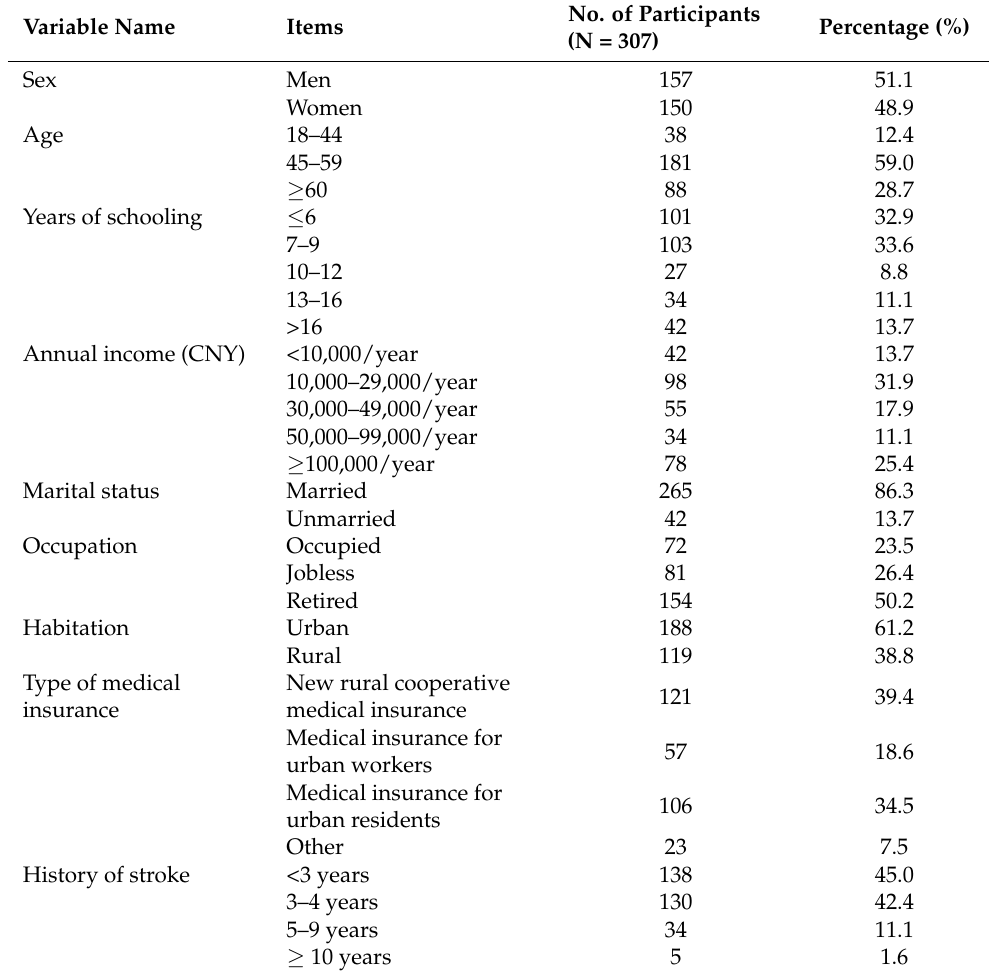
Table 1. Demographics of patients with stroke (N =